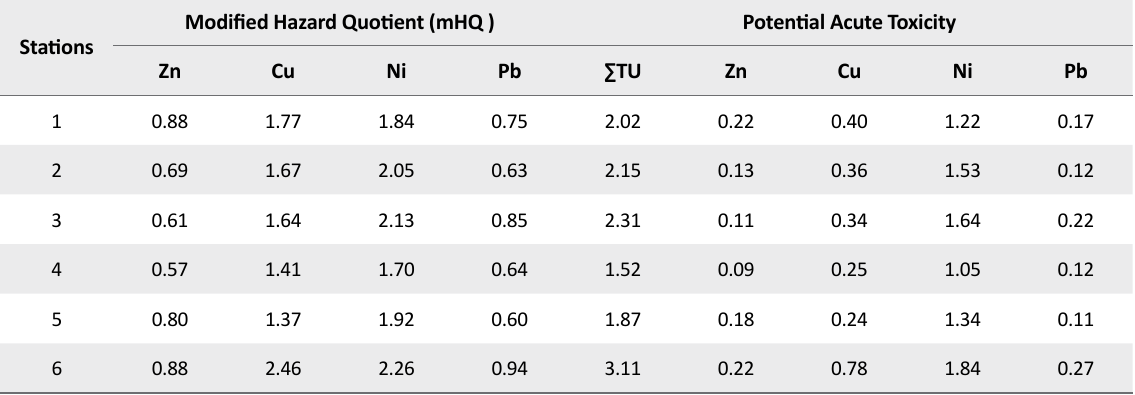
Table 5. Results of acute metal toxicity potential index values and modified Hazard Quotient (mHQ) in the soil of different stations